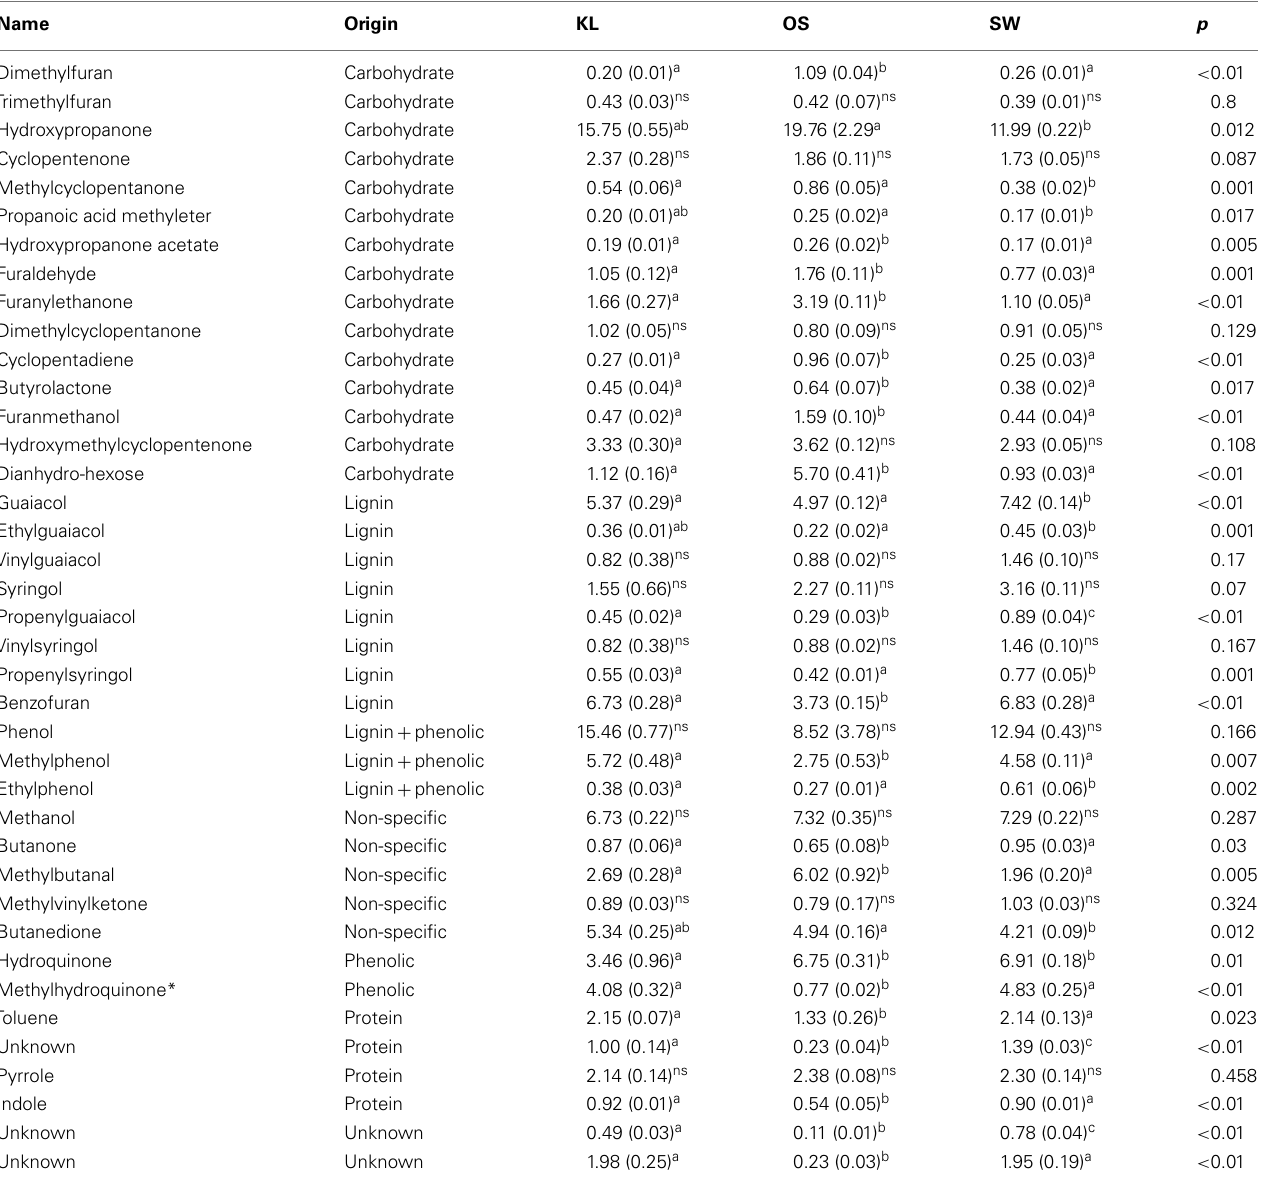
Table 1 | Lists the 39 pyrolysis products analyzed using